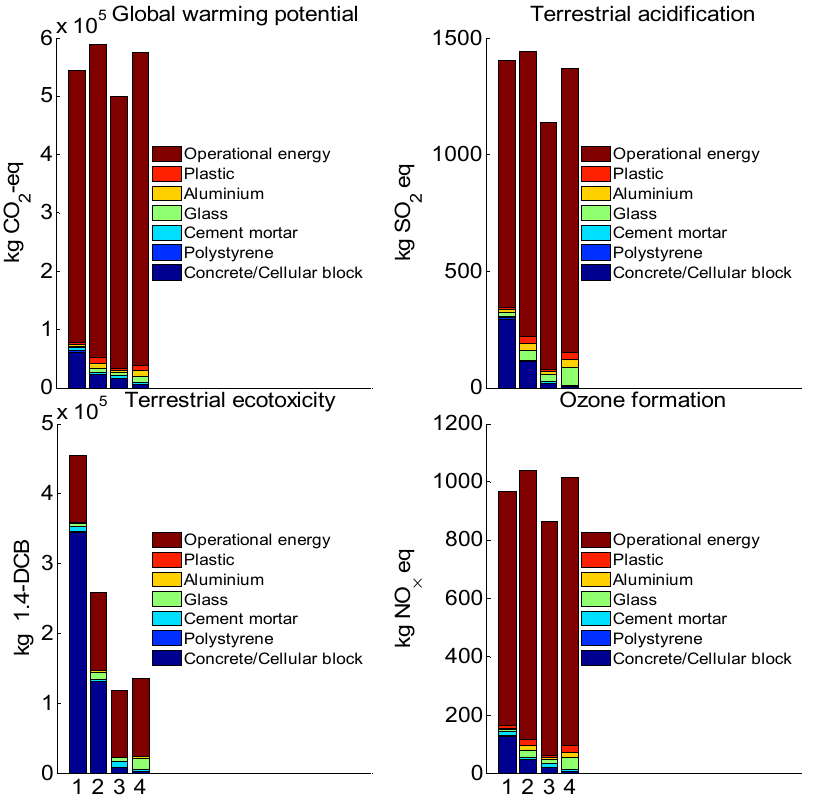
Figure 5. P&R and OE stages (OE stage with 8% coal + 57% natural gas + 35% PV-based electricity): environmental impact of CB MinWin (1), CB MaxWin (2), AAB MinWin (3), and AAB MaxWin (4), evaluated with ReCiPe2016 midpoint method, hierarchist (H) methodological option.